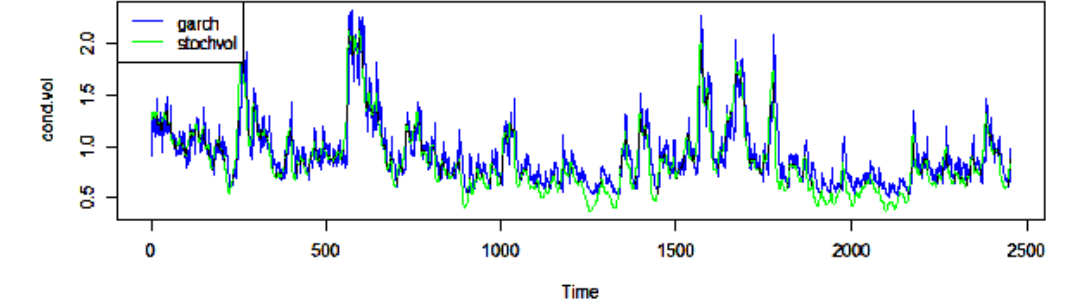
Figure 6. Conditional volatilities: SV and GARCH